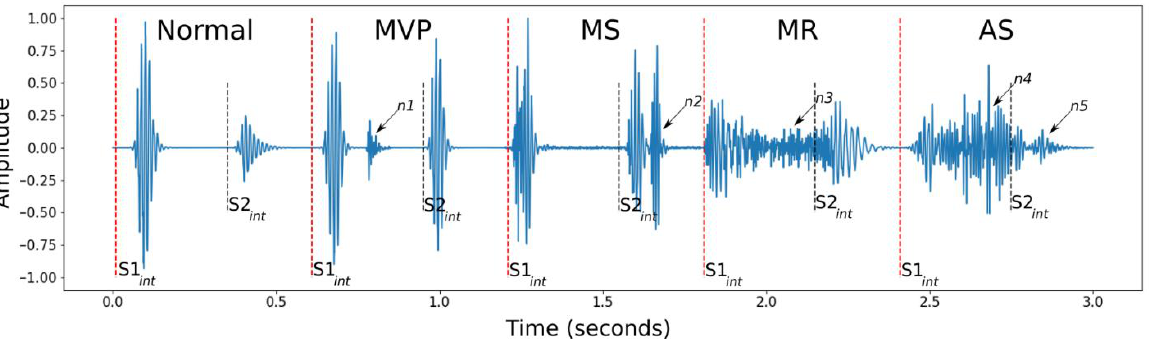
Figure 1. Cardiac acoustics and sounds from several phono cardiographic recordings. The average time between S1 and S2 in a normal heartbeat is between 70 and 150 ms. The duration of the entire cardiac cycle is roughly 800 ms. (S1: the sound when the mitral and tricuspid valves close to start systole; S2: the sound when the aortic and pulmonic valves close to start diastole). MVP: Mitral valve prolapse, AS: Aortic Stenosis, MR: Mitral Regurgitation, MS: Mitral Stenosis (Image reused with permission [7]).